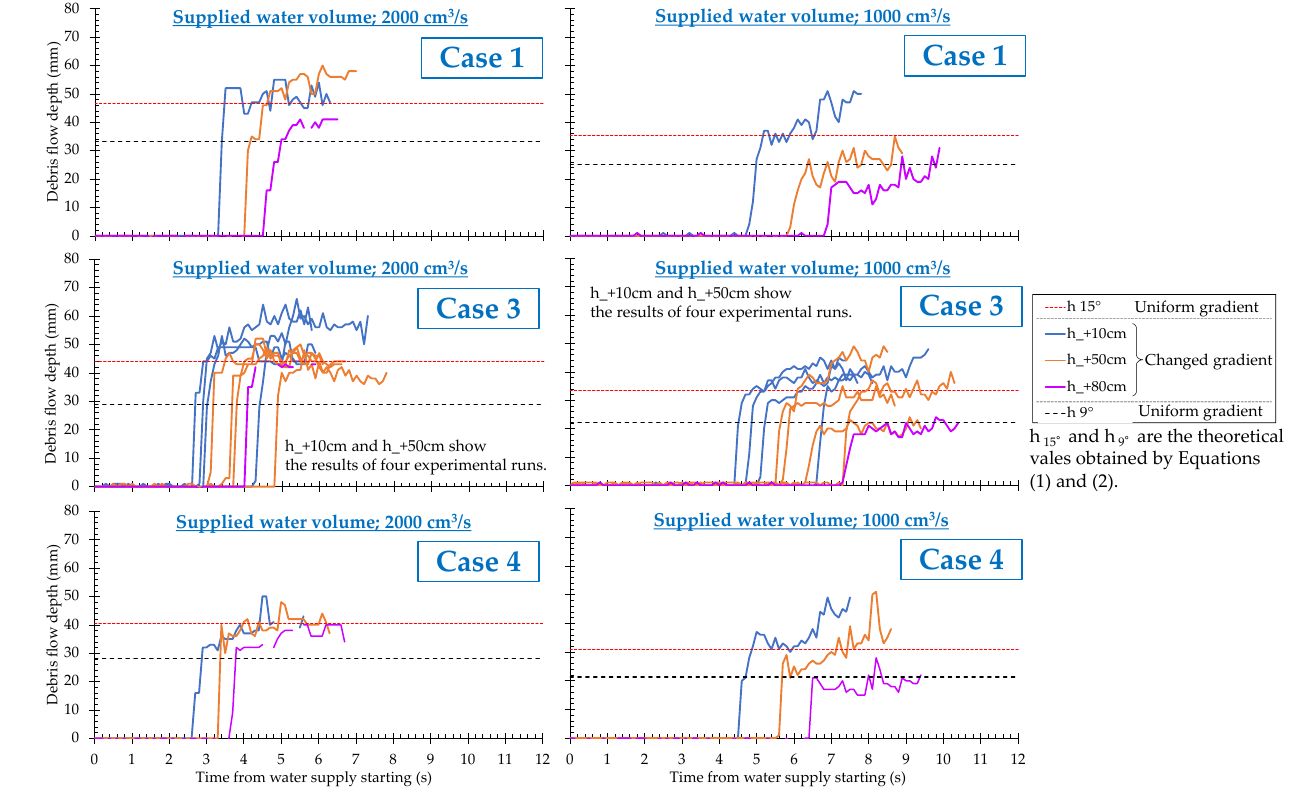
Figure 4. Time variations in debris flow depths of the “frontal part” of the debris flow, h , for all gradient conditions in Cases 1, 3, and 4. Table 3. Averaged debris flow depths of the “frontal part”, h , and theoretical debris flow depths on the uniform gradients, h 15 ◦ and h 9 ◦ , for all cases with two inflow rates (unit;